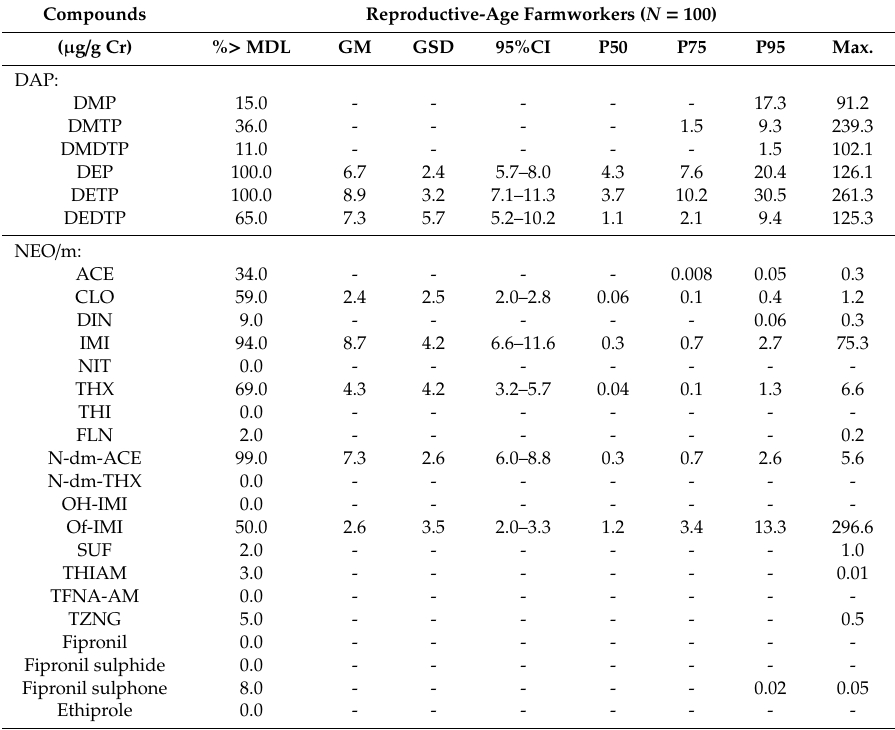
Table 1. Urinary DAP and NEO / m concentrations in reproductive-age farmworkers ( N = 100). Compounds Reproductive-Age Farmworkers ( N =